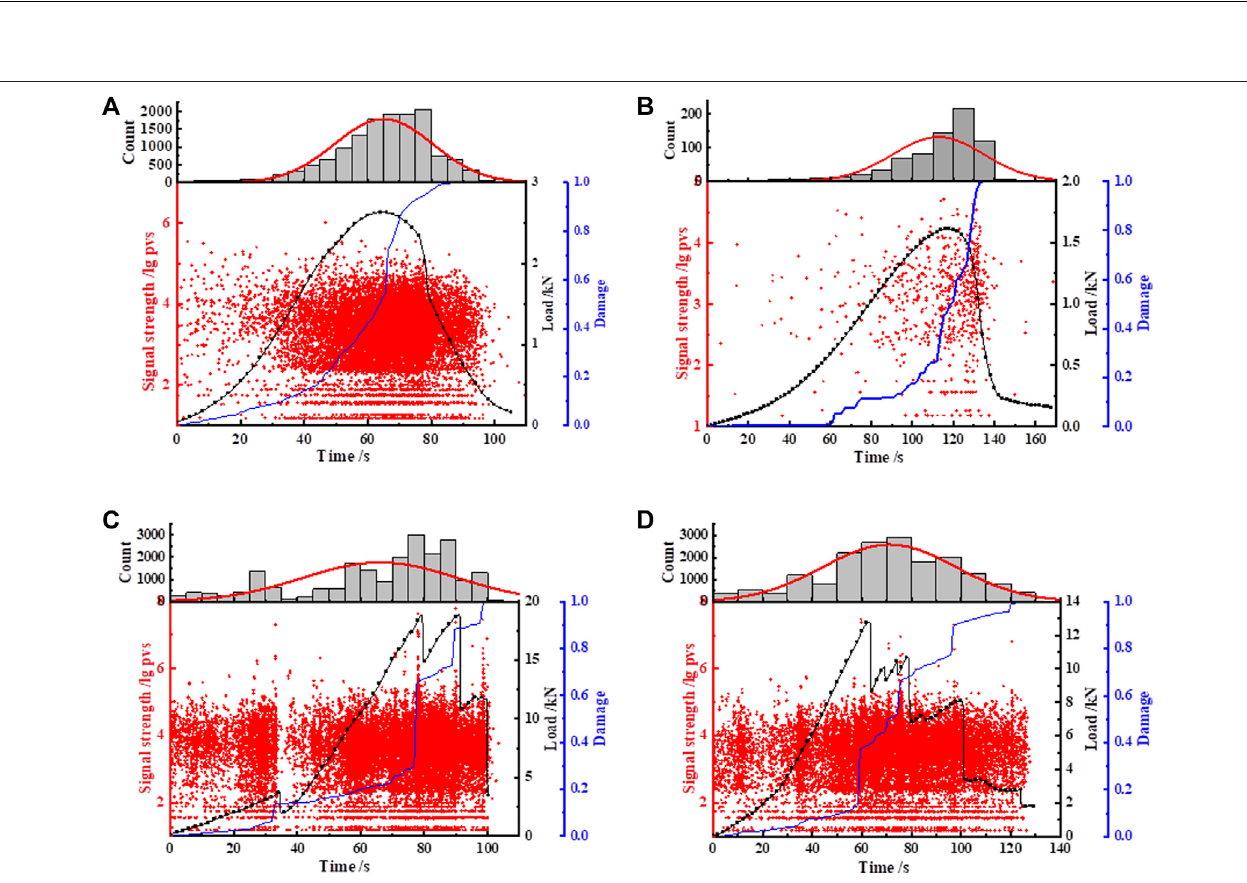
Frontiers in Earth Science |